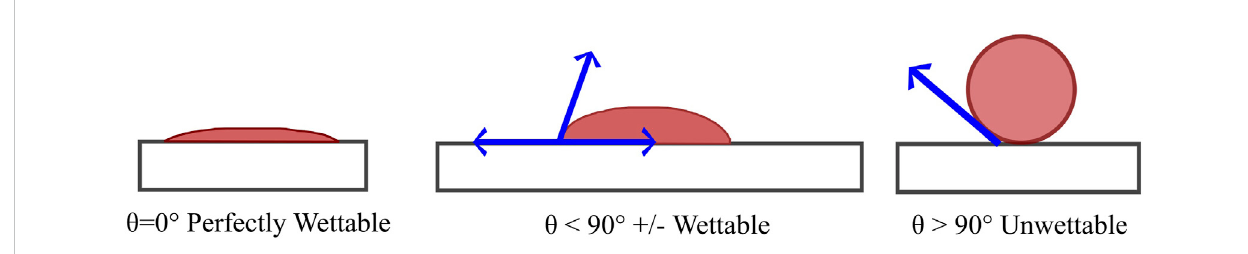
FIGURE 3 Wettability and contact angle of a